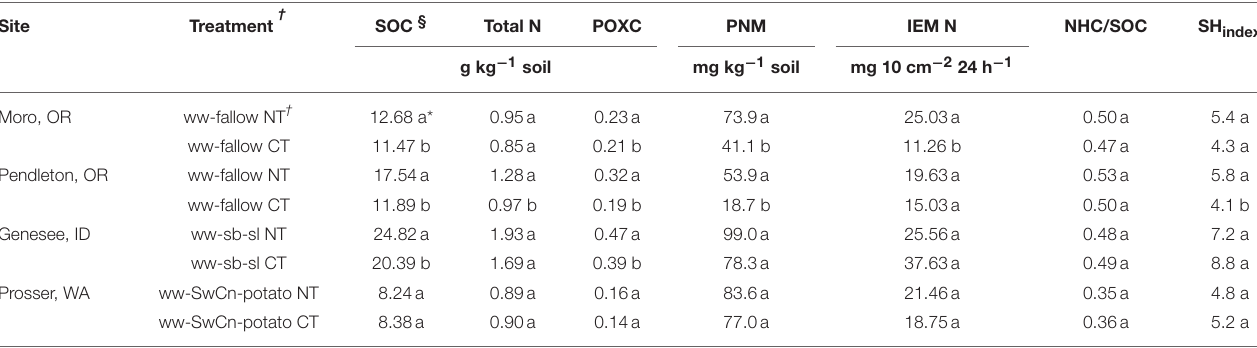
† ww, winter wheat; sb, spring barley; sl, spring legume; sc, spring cereal; SwCn, sweet corn; CT, conventional tillage; NT, no-till. § SOC, soil organic C; Total N, total soil N; POXC, permanganate oxidizable C; PNM, potentially mineralizable N; IEM N, N adsorbed to ion exchange membrane after 24h;